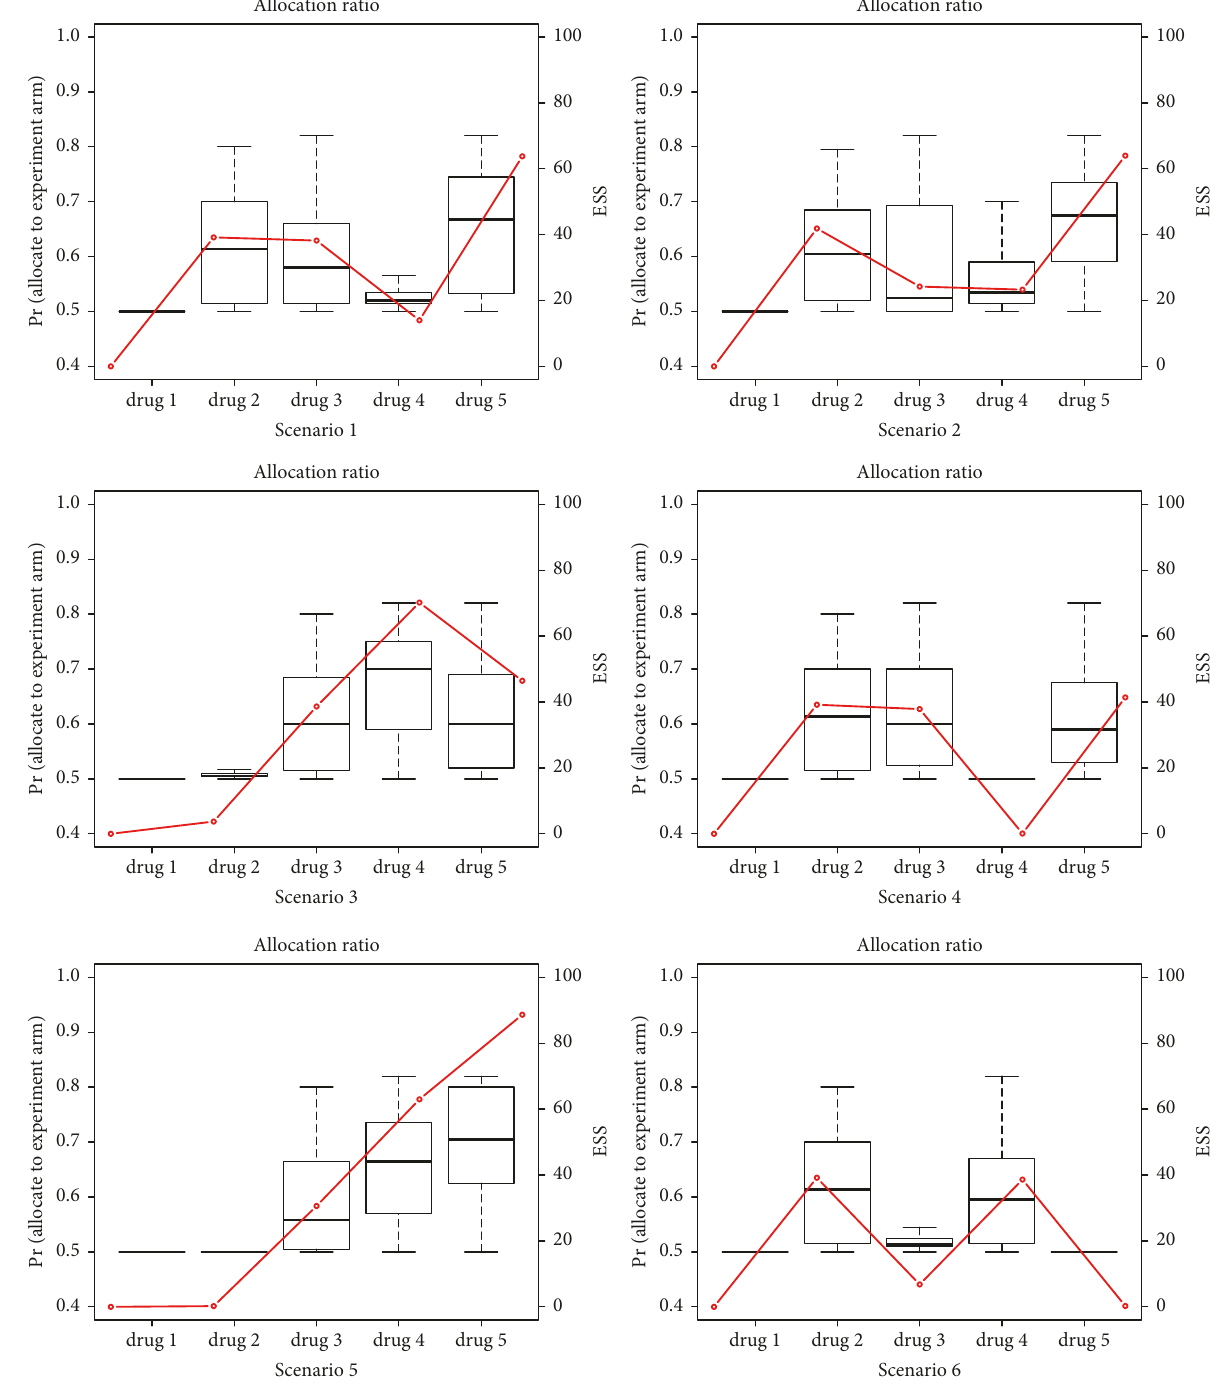
Figure 3: Proportion of patients assigned to the experimental arm and effective sample size using time trend